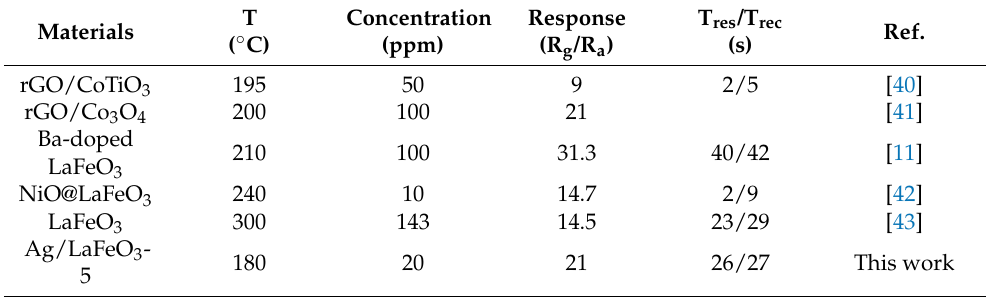
Table 1. Comparison of sensor-based ethanol gas detection characteristics with different detection